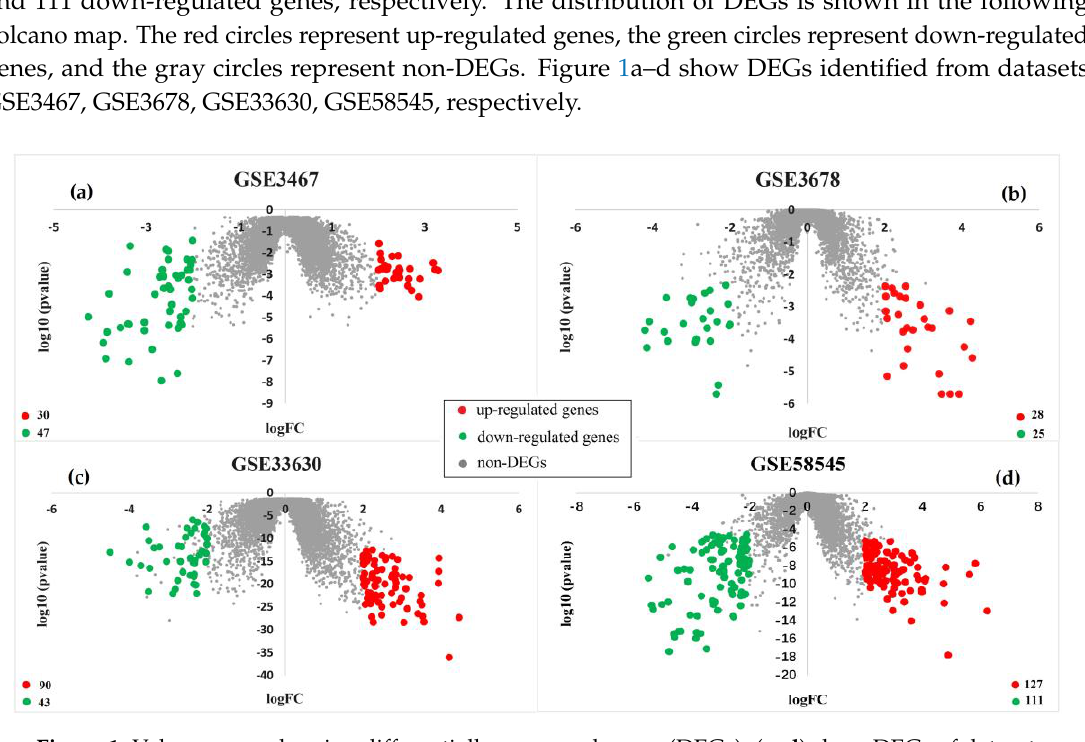
Figure 1. Volcano map showing differentially expressed genes (DEGs). ( a – d ) show DEGs of dataset GSE3467, GSE3678, GSE33630, and GSE58545,